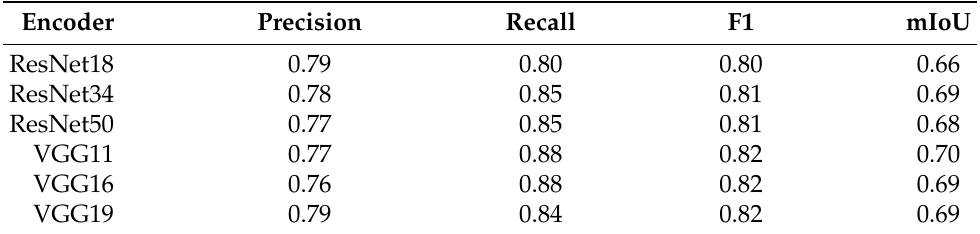
Table 1. ResNet and VGG encoders yield comparable performance measures for the binary change detection task. The ResNets slightly outperform the VGGs in precision, the VGGs slightly outperform the ResNets in recall, and they have higher F1 and mIoU scores